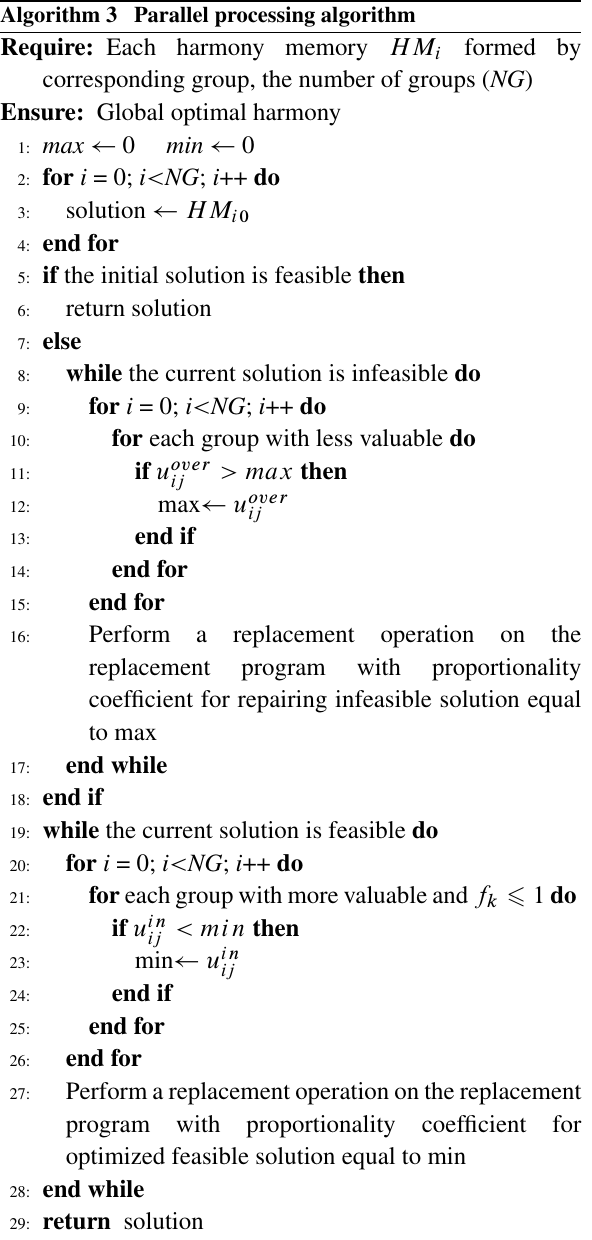
Algorithm 3. The major steps of the parallel processing algorithm are as follows. Algorithm 3 Parallel processing